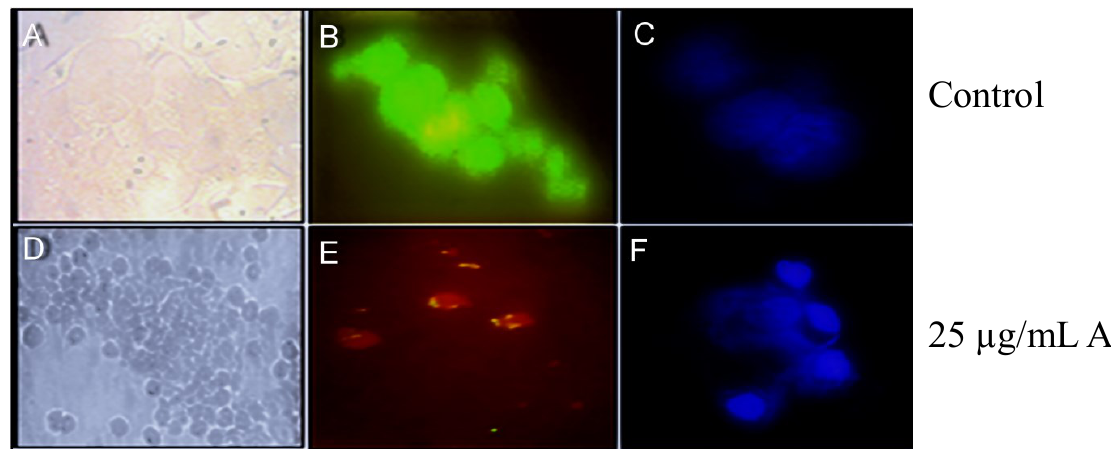
Figure 7. Comparing morphological change assess in MCF7 cells that treatment with Ag-NPs and Control ( A ) light microscopy image of control; ( B ) AO staining in control group; ( C ) DAPI staining of control group; ( D ) Ag-NPs caused significant cell death; ( E ) staining with AO, 25 µg/mL Ag-NPs caused 50% cell death; ( F ) DAPI staining shows fragmentation of nucleic acid after treatment (24 h).